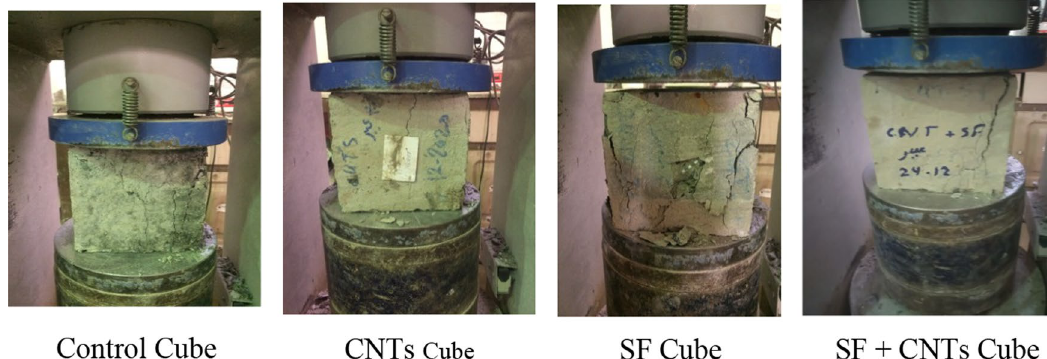
Fig. 14 Failure modes of the cubes made from various